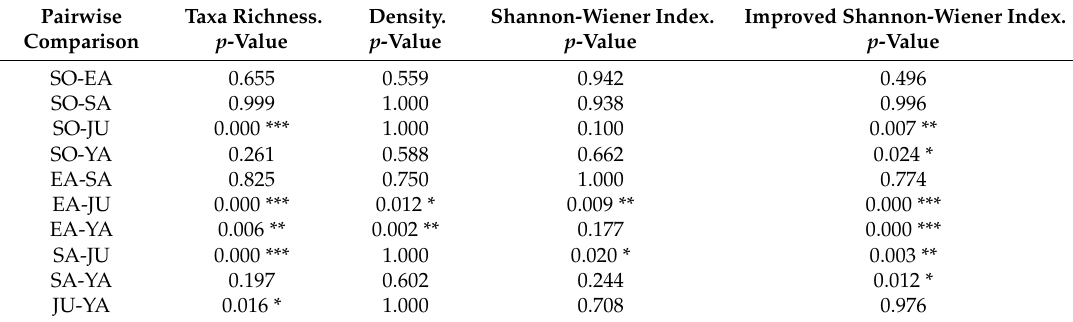
Table 4. Pair comparison among each of the alpha diversity indices of the five rivers based on post-hoc test. Pairwise Taxa Richness. Density. Shannon-Wiener Index. Improved Shannon-Wiener Index. p -Value p -Value p -Value p -Value Comparison SO-EA 0.655